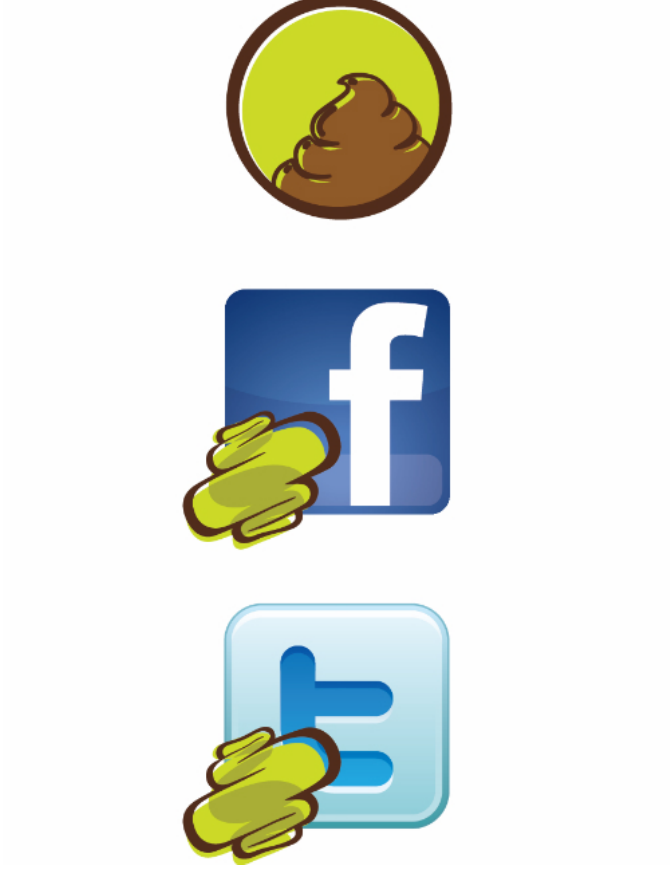
Figure 1. Blog, Facebook, and Twitter logos for HD campaign.